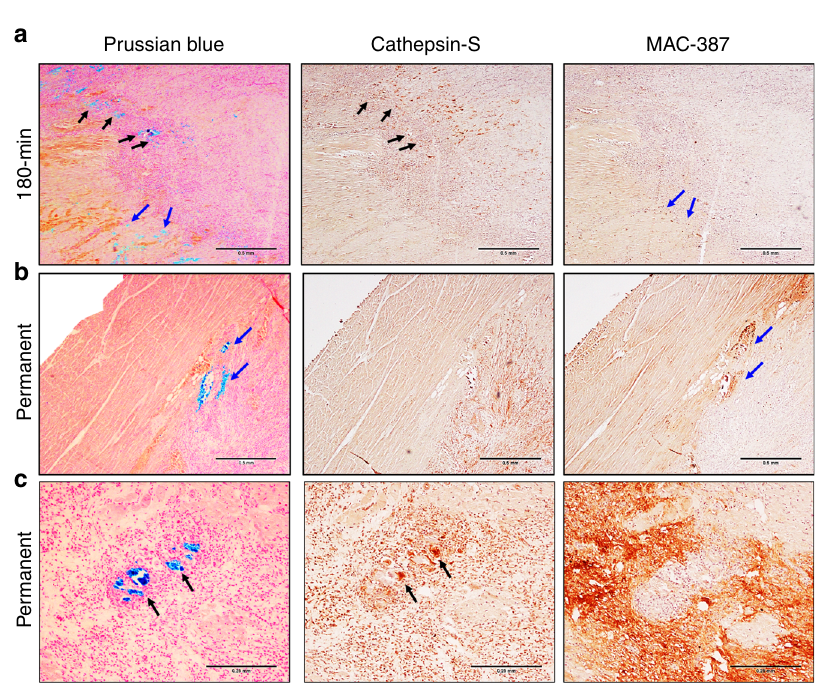
Fig. 4 Immune response and iron deposition in reperfused and permanent infarcts. a Representative 180 min reperfused infarct at 1 week post-infarction shows regions of iron accumulation at the transition zone between myocyte necrosis and mixed viable myocytes (Prussian blue, black, and blue arrows) colocalized with MHC class II antigen-presenting cells (Cathepsin-S, black arrows) and newly recruited macrophages (MAC-387, blue arrows). b , c Representative permanently occluded infarct at 1 week post-infarction also had heterogeneous macrophage aggregation with newly recruited macrophages (MAC-387, blue arrows) and MHC class II antigen-presenting cells (Cathepsin-S, black arrows) colocalized with iron accumulation (Prussian blue, black, and blue arrows). Histology was repeated in independent tissue sections for 90 ( n = 2), 180 min ( n = 2) reperfused, and permanent ( n = 2) infarcts which showed similar histopathological fi ndings within reperfused and permanent infarct groups. a and b are at ×40 magni fi cation and c is at ×100 magni fi